Question: Judging by this figure, is the value going up or going down?
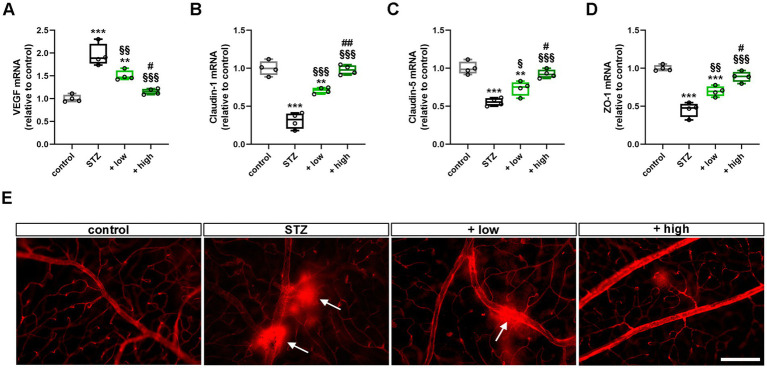
Answer: increasing